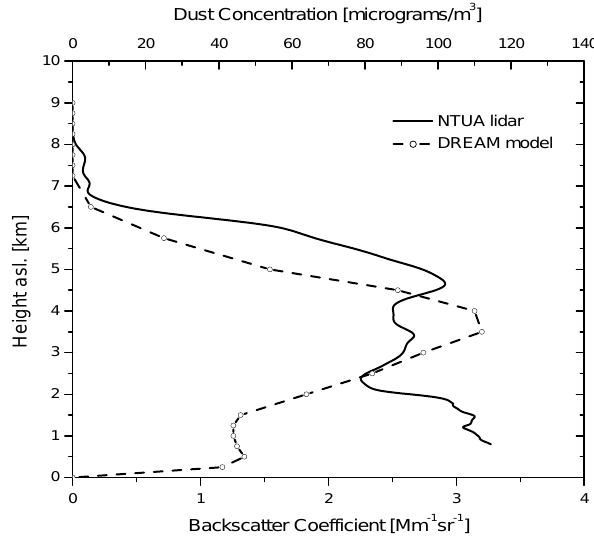
Fig. 4. Aerosol backscatter coefficient obtained by NTUA lidar at 532nm on 11 of July 2005 at 18:00UTC, along with the cor- responding dust concentration profile estimated by the DREAM